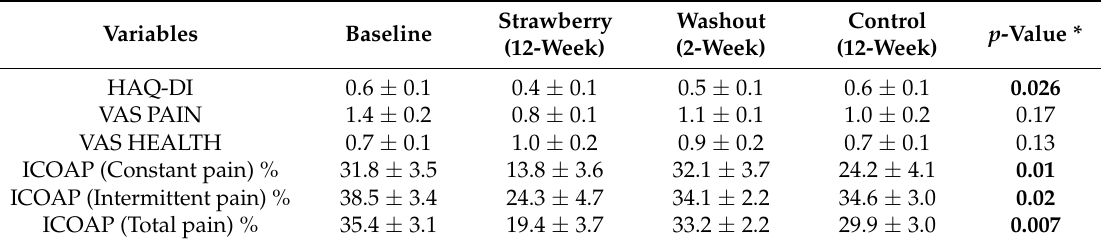
Table 5. Measures of knee pain and quality of life indicators following strawberry and control interventions in a 26-week crossover trial in obese adults with symptomatic knee osteoarthritis ( n = 17/group).